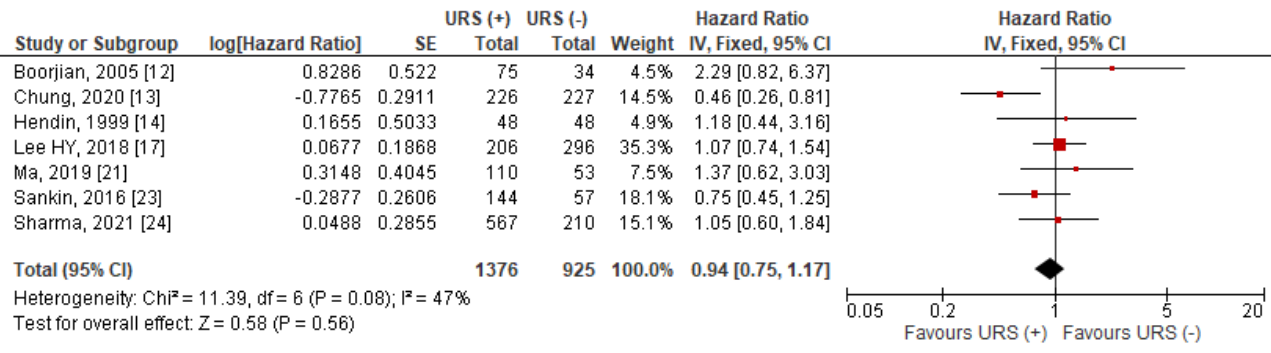
Figure 5. Forest plot and meta-analysis of overall survival (OS) [12,13,14,17,21,23,24]. CI = confidence interval; IV = inverse variance; SE = standard error; URS = ureteroscopy.